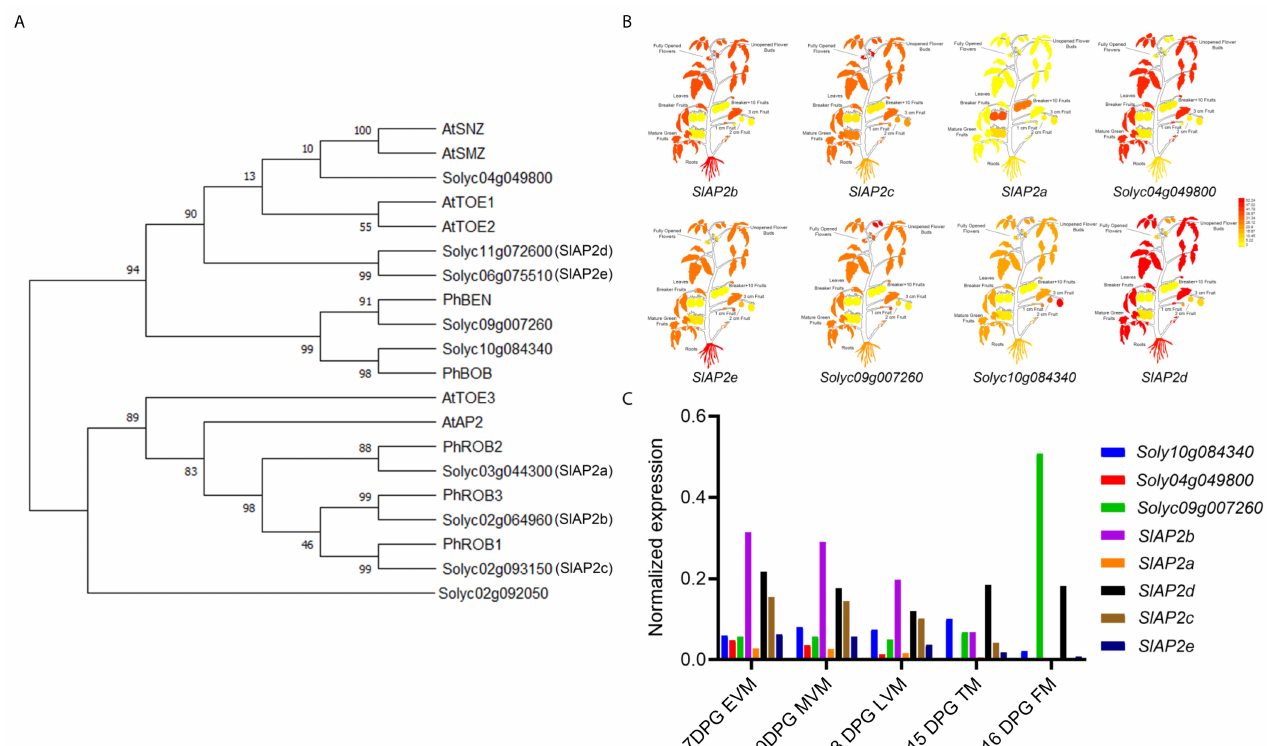
Figure 7. Characterization of SlAP2 genes predicted to be targeted by sly-miR172c and sly-miR172d. ( A ) A rooted phylogenetic tree based on the protein sequences of Arabidopsis (At), petunia (Ph) and tomato eu-AP2 transcription factors. The Solyc02g092050 protein sequence served as an outgroup. The tree was constructed using FastTree v2.1.8 with default parameters [34]. ( B ) Tissue based expression profiles of indicated genes in tomato CV Heinz. Yellow and red indicate, weak and strong expression, respectively. Expression data was retrieved from the ePLANT database (http://bar.utoronto.ca/ eplant_tomato/, accessed on 1 January 2021). ( C ) Normalized expression levels of indicated genes in vegetative and flower meristems. Expression data was retrieved from the TomExpress database (http://tomexpress.toulouse.inra.fr, accessed on 1 January 2021). EVM, early vegetative meristem; MVM, mature vegetative meristem; LVM, late vegetative meristem; TM, transition meristem; FM, flower